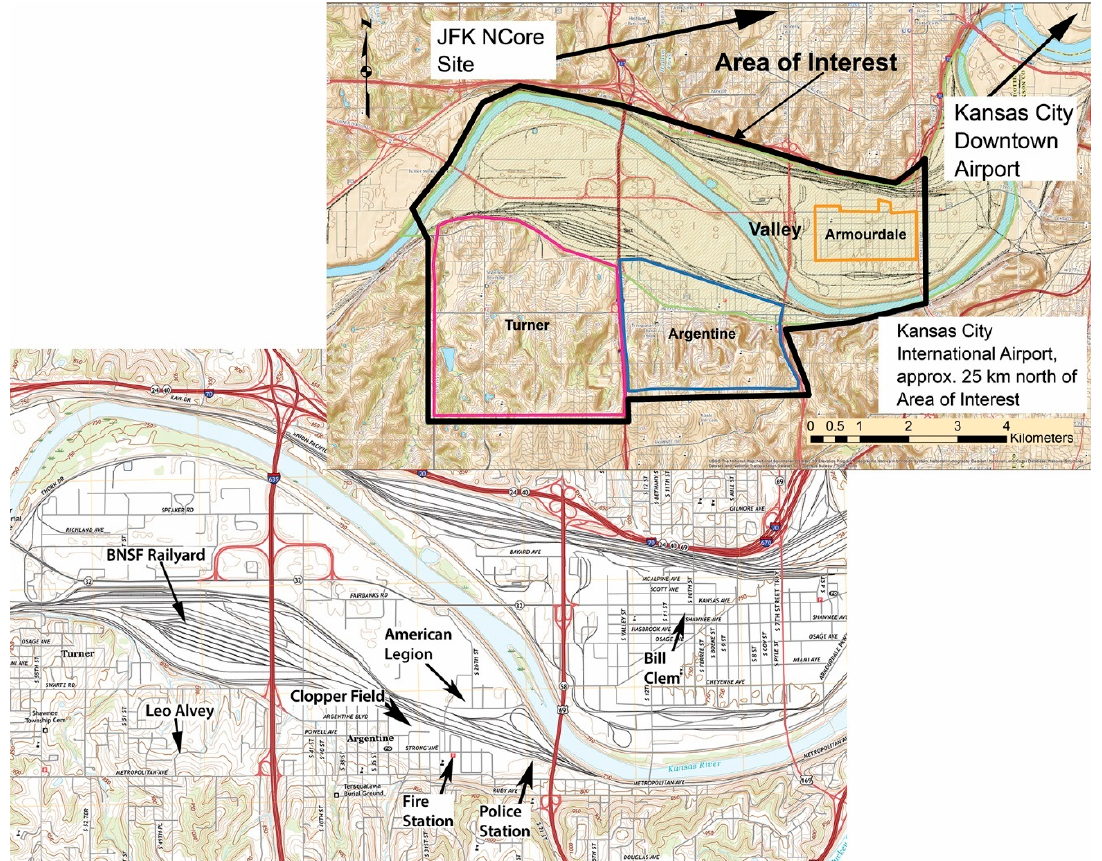
Figure 1. Kansas City Transportation and Local-Scale Air Quality Study (KC-TRAQS) Area Maps.